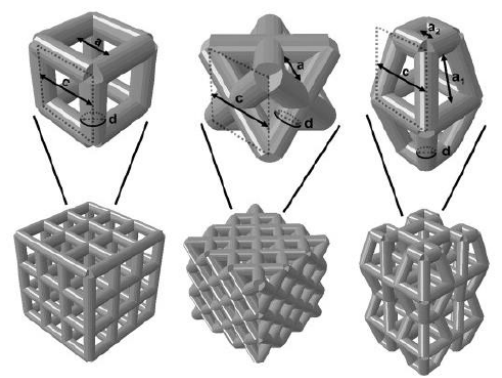
Figure 7. Upper Row: Parameterized models of the cubic structure ( left ), diagonally orientated struts ( middle ) and modified truncated pyramid ( right ) with the strut diameter (d), size of the basic cell (c) and pore size (a). Bottom Row: Mechanically tested scaffolds, consisting of 3 × 3 × 3 basic cells (cubic and diagonal design) and 2 × 2 × 2 basic cells for the modified truncated pyramid design (with additional connection elements). Struts are shown as cylindrical beams with their analytical cross-section [122].